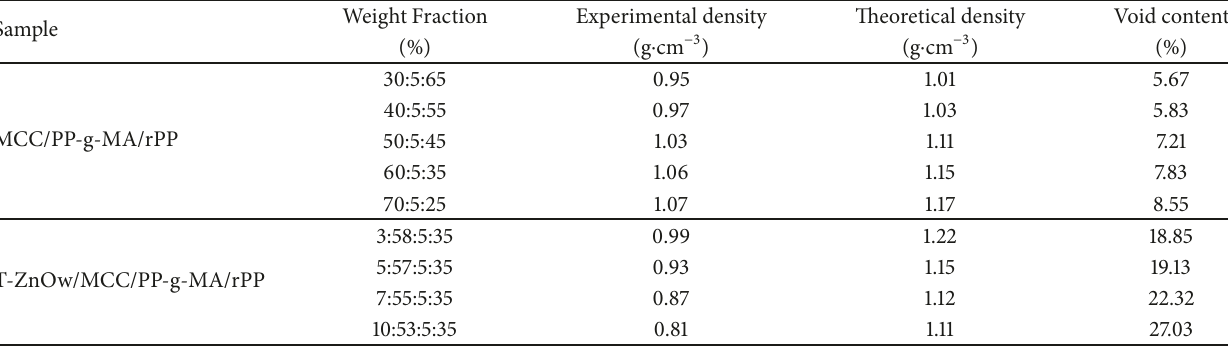
Table 2: Density and void content of